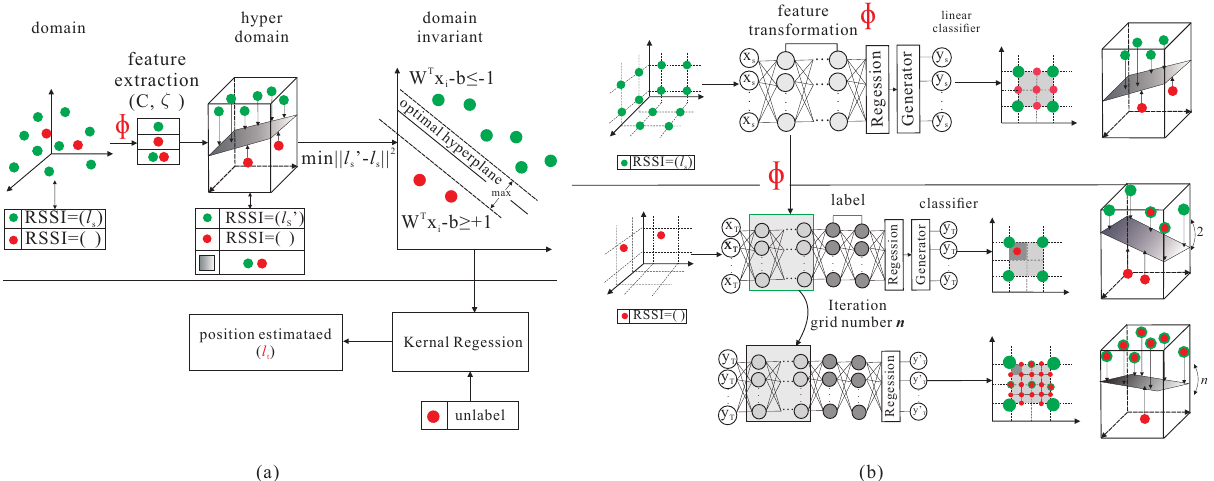
Figure 4. Basic idea of grid localization.